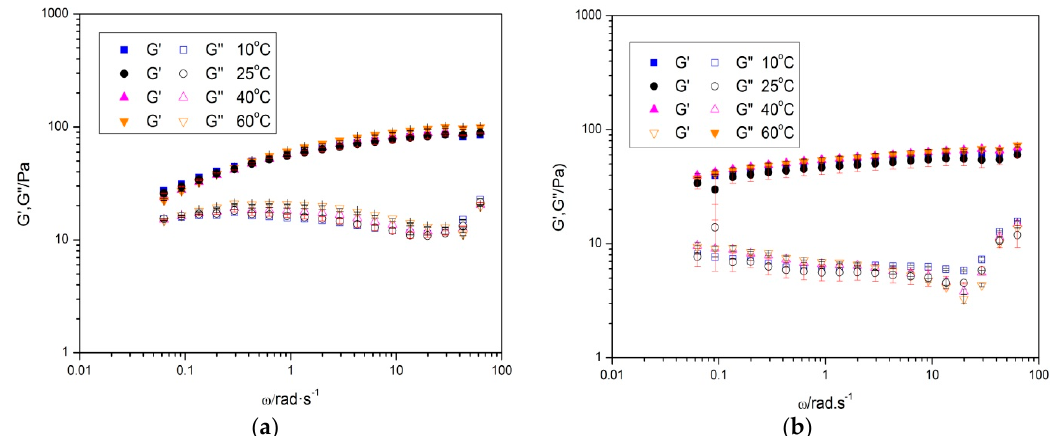
Figure 3. Influence of the temperature on the mechanical spectra of ( a ) 1 wt % diutan gum and ( b ) 1 wt % rhamsan gum.